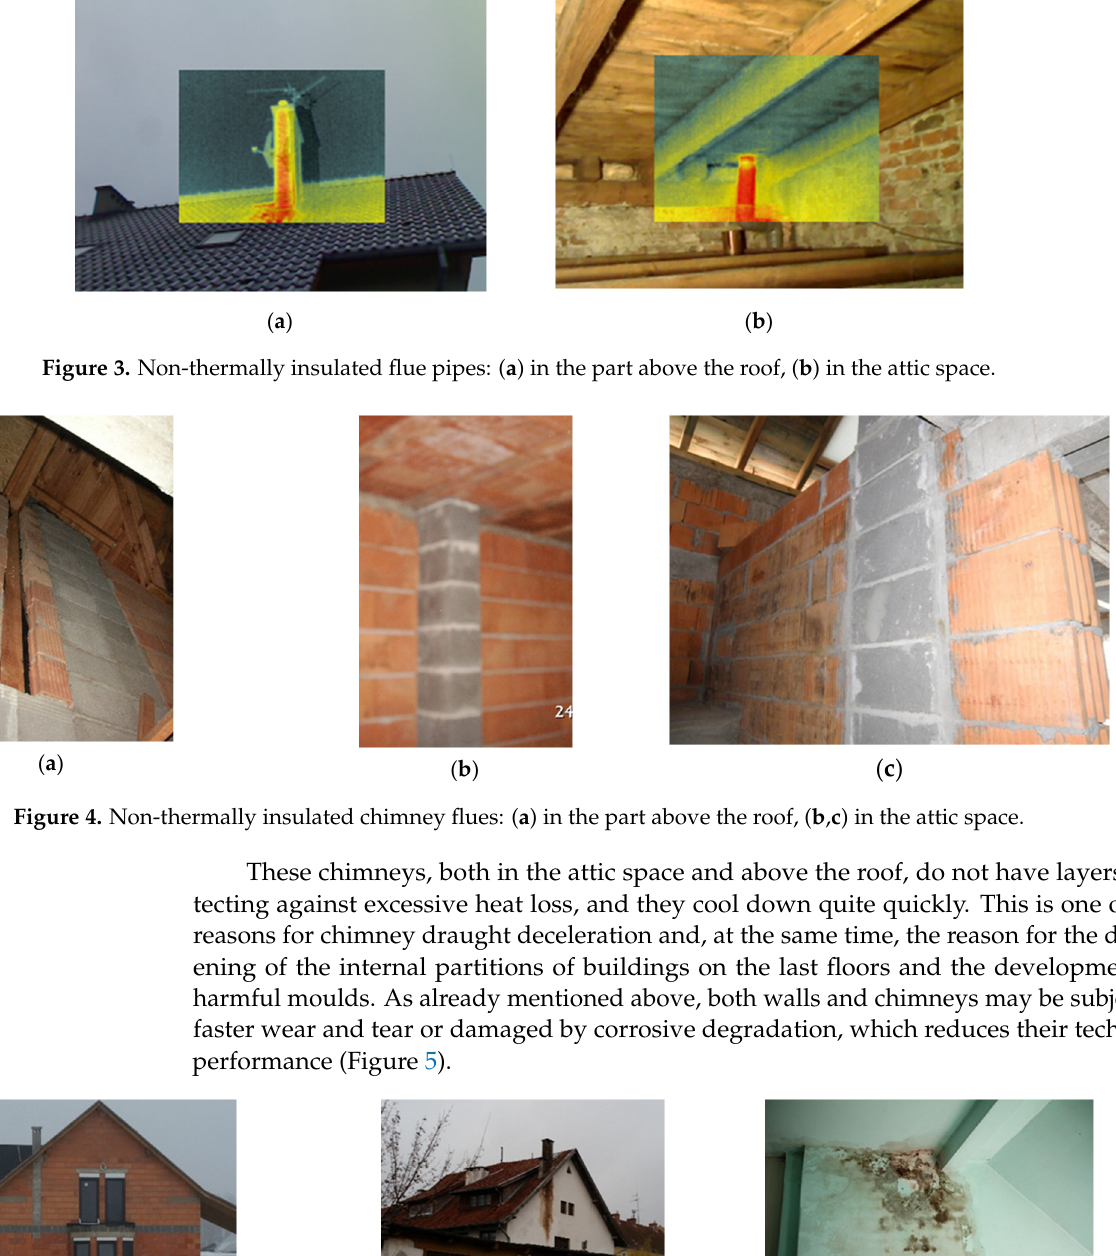
Figure 5. Consequences of inadequate protection of external and internal chimney walls ( a , b ) elevation, ( c ) inside. This can lead to serious mechanical damage to chimneys and even entire buildings.